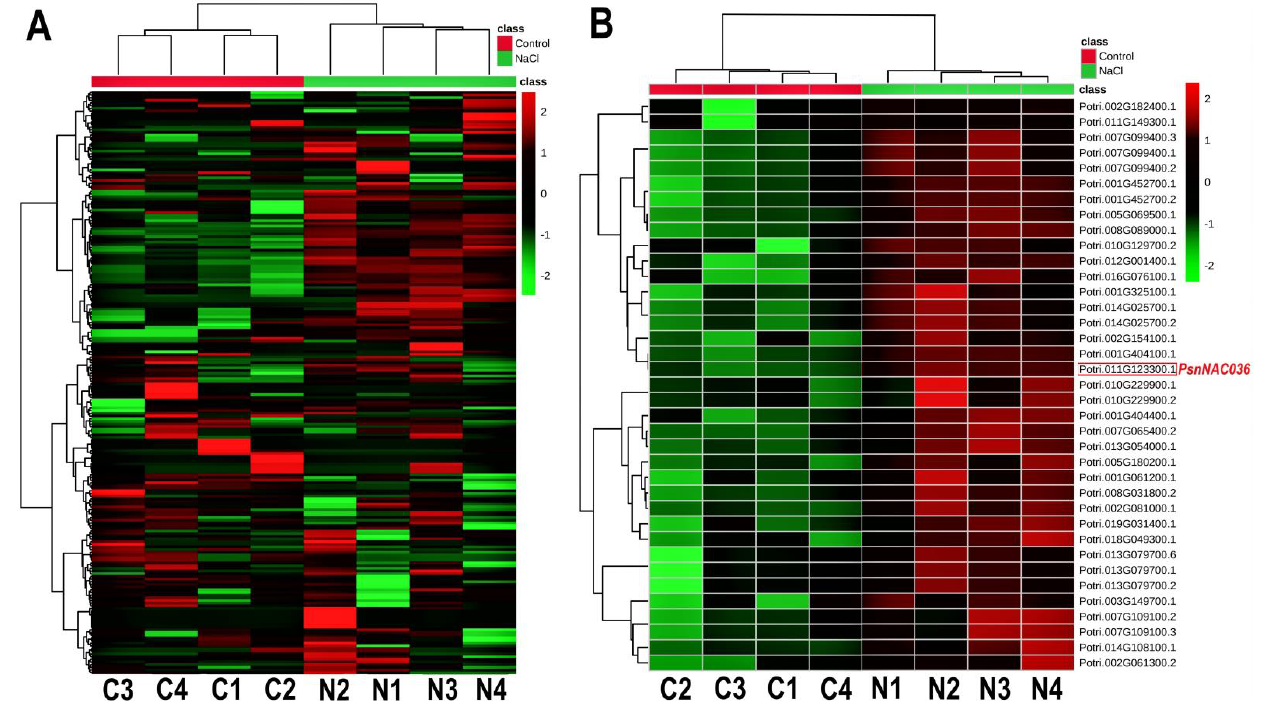
Figure 1. Heatmaps of the relative expression of NAC genes in control and NaCl treated P. simonii × P. nigra seedlings. ( A ) Relative expression patterns of 289 NACs in salt stress versus control. ( B ) Heatmap of the 37 differentially expressed NAC s. Red and green colors indicate high and low expression, respectively. The colored scale bar represents fold changes of transcription levels betweenNaCl stress and control. C1, C2, C3, and C4 represent the four biological replicates under control conditions; N1, N2, N3, and N4 represent the four biological replicates under NaCl stress.